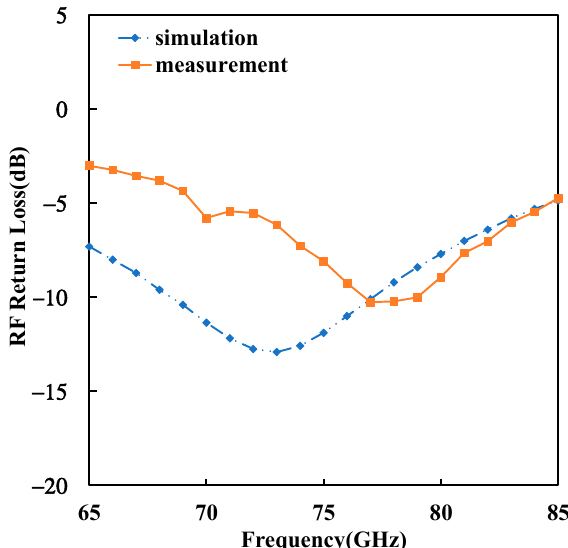
Figure 15. The return loss of the receiver.